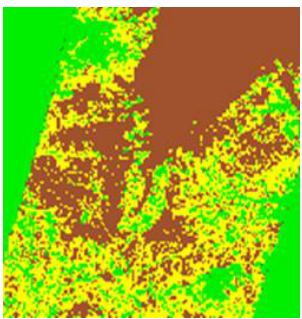
Figure 2. NDVI Vegetation Delineation